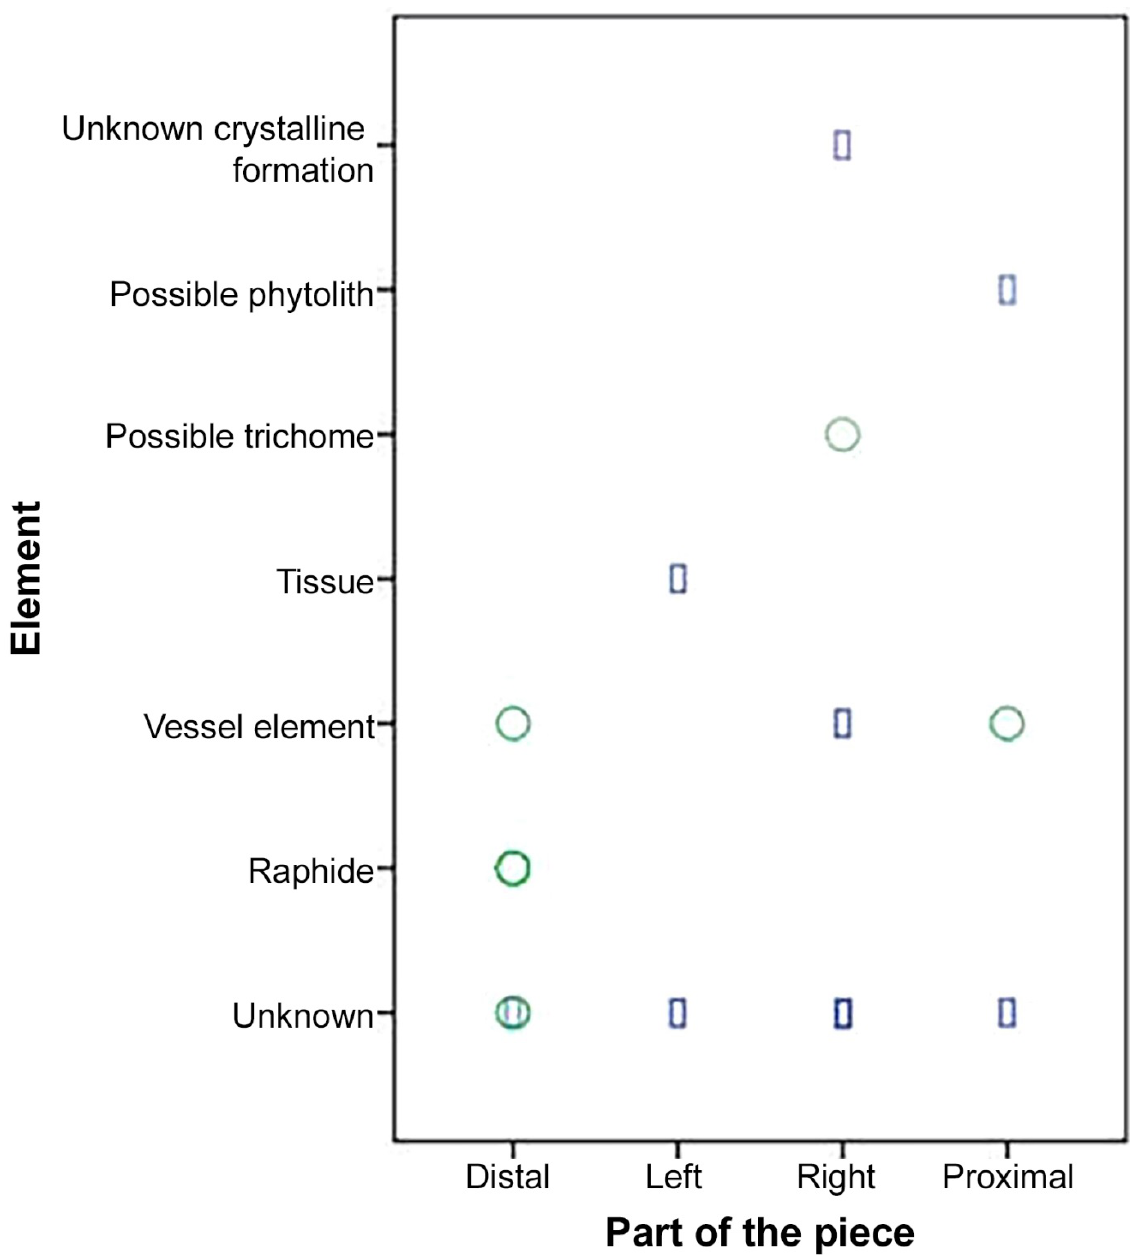
Figure 12. Other elements found in different parts of the tool. Elements recovered from sediment I are represented by blue rectangles, elements recovered from sediment II are represented by green